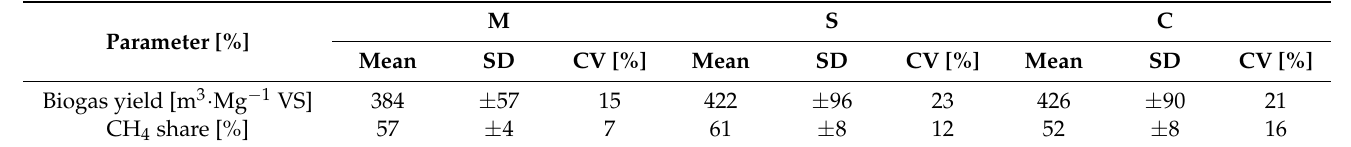
Table 4. Average biogas yields and biomethane from SS-OFMSW generated in different sources (M, S, C).